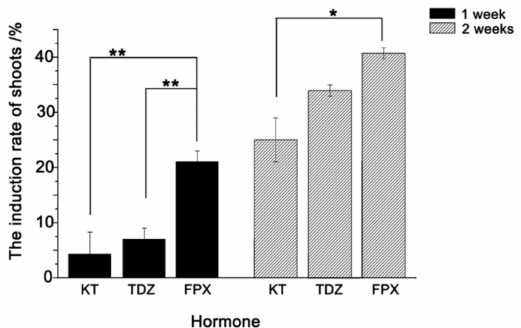
Figure 2. Comparative analysis of shoot induction between KT, TDZ, and FPX. The induction rates of shoots were counted after one and two weeks culturing. The black bar and gray bar represent the induction e ffi ciency of shoots under di ff erent hormones after one and two weeks, respectively. For each treatment, three replicates were conducted. The results indicated that significant di ff erences were found between FPX and the other two chemicals of KT and TDZ after one-week growth. After two weeks, significant di ff erence was found between FPX and KT treatments. Error bars represent ± SE, n = 3. Asterisk indicates significant di ff erence relative to FPX (Student’s t test, * p < 0.05 and ** p <